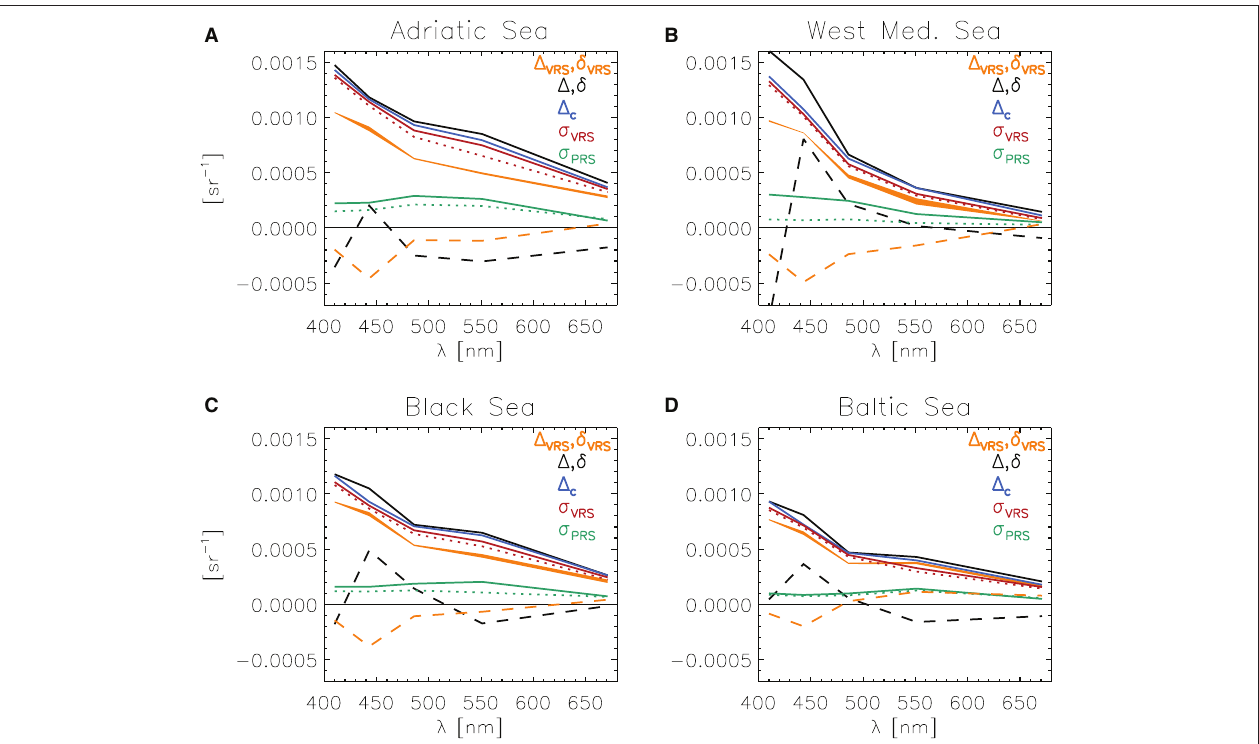
FIGURE 5 | Spectra of statistical quantities for VIIRS-SNPP for sites in (A) the Adriatic Sea, (B) the Western Mediterranean Sea, (C) the Black Sea, and (D) the Baltic Sea. Comparing SNPP and PRS field data: 1 is the RMS difference (solid line), δ is the average difference (dashed line) and 1 c is the centered RMS difference. Comparing VIIRS SNPP and JPSS1 data, 1 PRS is the RMS difference (sold line), δ VRS is the average difference (dashed line, JPSS1-SNPP). σ PRS is the uncertainty associated with PRS field data (solid green line); the average standard deviation of the measurements used for each match-up is shown with a dotted green line. σ VRS is the SNPP uncertainty term associated with random effects, without and with correction for representation error (solid and dotted lines, respectively). Note that 1 VRS and δ VRS are equally represented in Figure 6